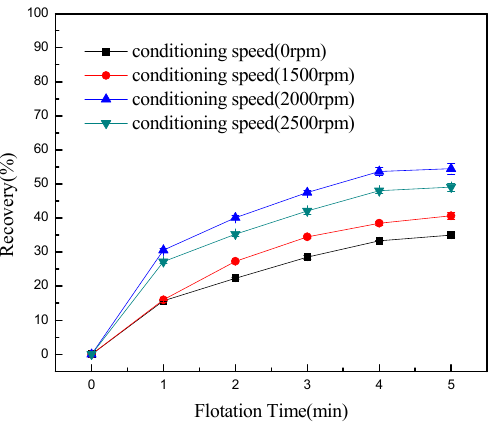
Figure 6. Effect of conditioning speed under natural atmosphere on the recovery of mixed minerals, with pyrrhotite and chlorite mixed at a ratio of 10:1 (pH = 9.0 ± 0.2; C(potassium amyl xanthate) = 1 × 10 − 4 mol/L; C(MIBC) = 1 × 10 − 4 mol/L; and Conditioning time = 5 min).